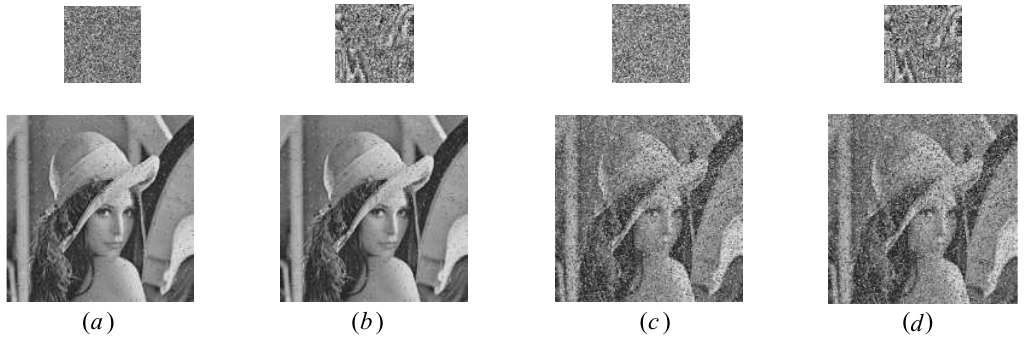
Figure 5. The results of resisting Gaussian noise. ( a ) the share with 1% Gaussian noise and the decrypted result ( b ) the share with 5% Gaussian noise and the decrypted result ( c ) the share with 10% Gaussian noise and the decrypted result ( d ) the share with 15% Gaussian noise and the decrypted